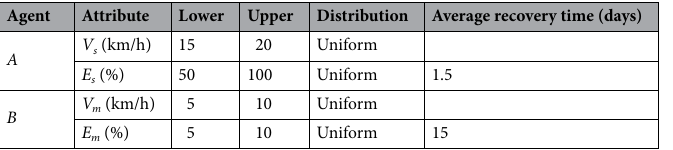
Table 2. Behavioural attributes of the